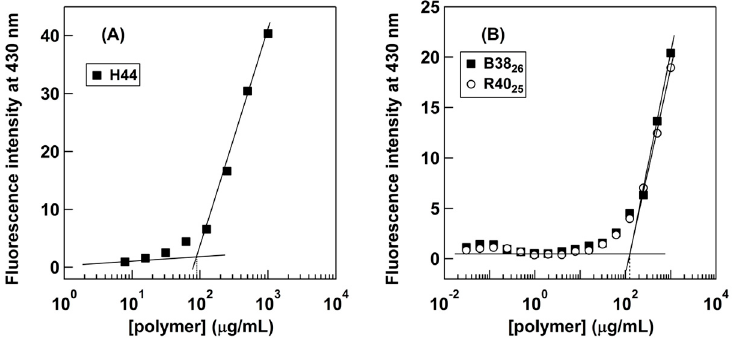
Figure 2. Fluorescence intensity of DPH (50 nM) versus polymer concentrations of ( A ) homopolymer, H44 and ( B ) poly(IBVE- co -AEVE)s with MP IBVE ~25 mol % in HEPES buffer (pH 7). The data points represent the average from duplicate measurements.